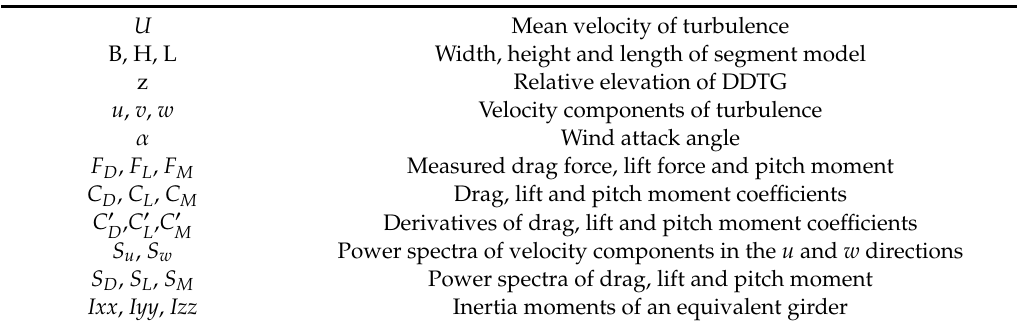
Table 1. List of